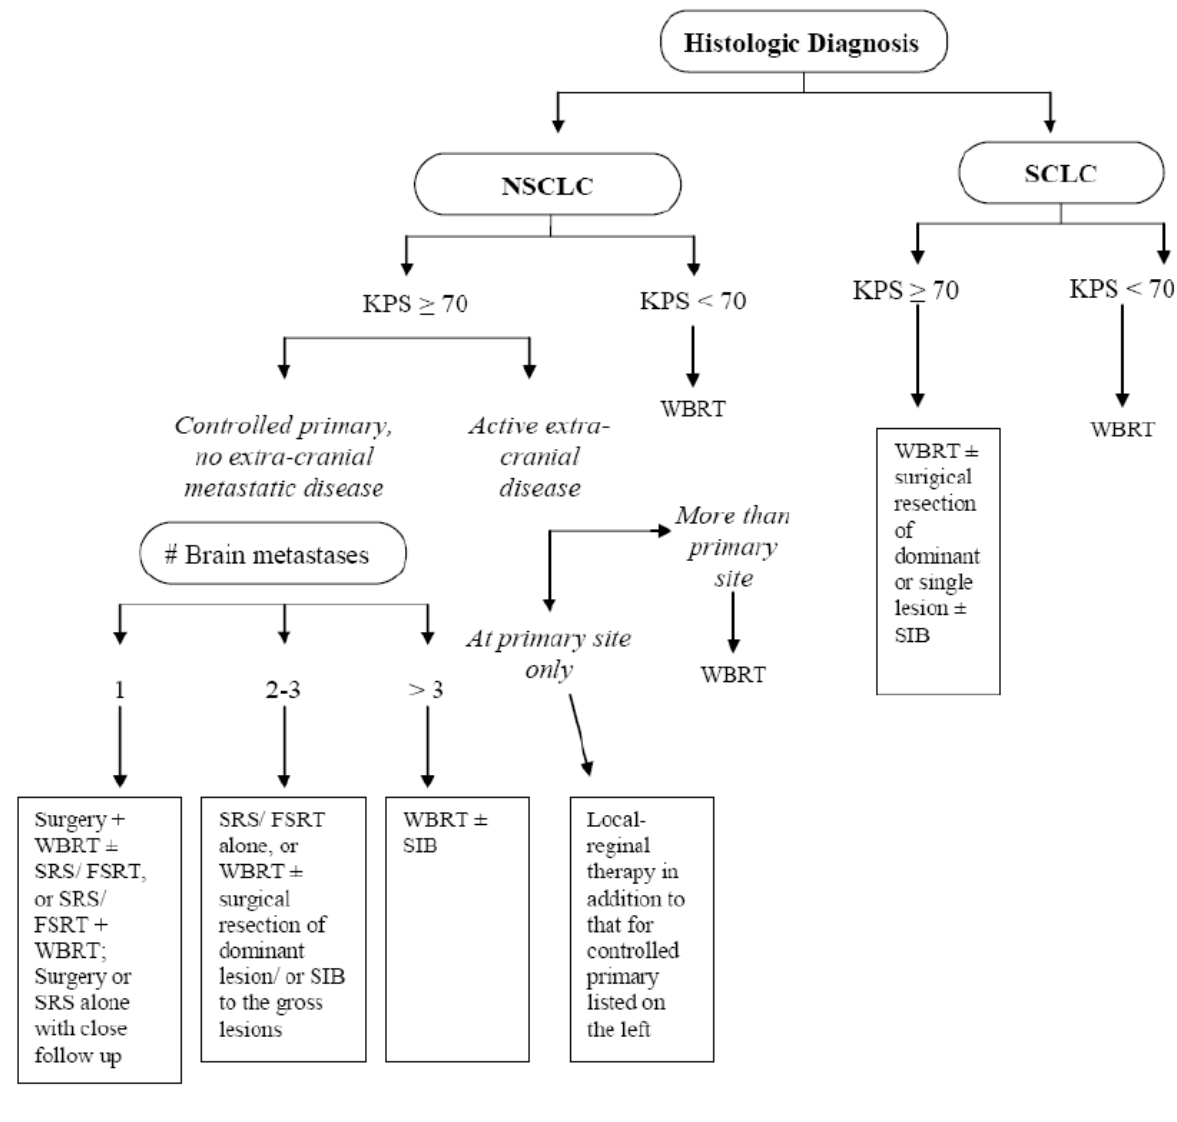
Figure 1. Algorithm for the initial treatment of brain metastases from lung